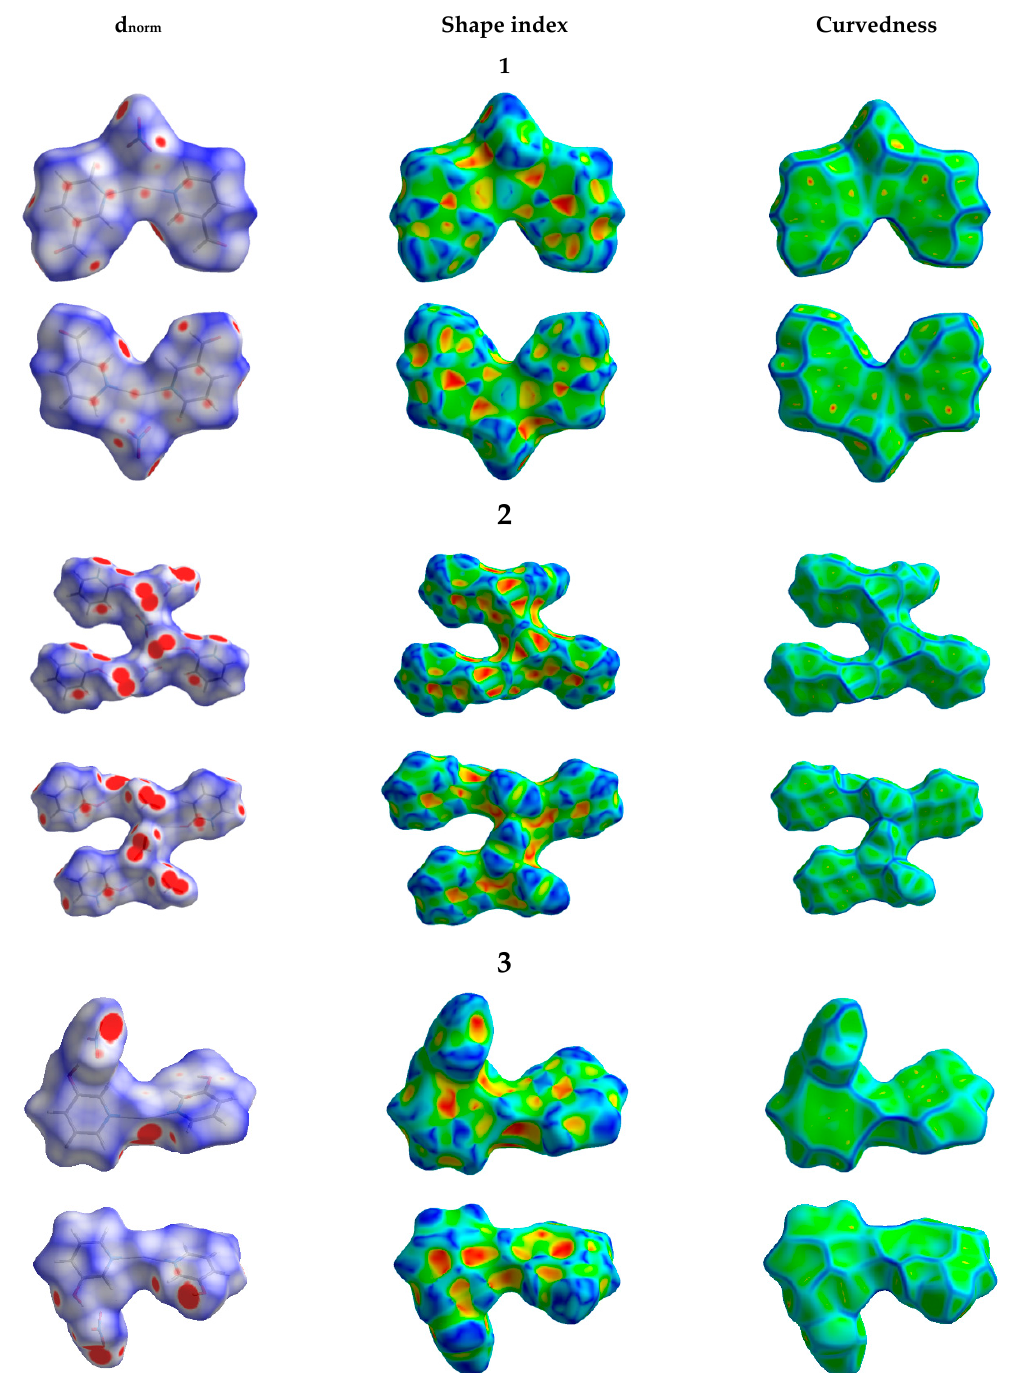
Figure 6. Hirshfeld analyses of [Ag(pyridine-3-carboxaldhyde) 2 NO 3 ]; ( 1 ), [Ag 3 (2-pyridone) 3 (NO 3 ) 3 ]; ( 2 ), and [Ag(3-hydroxypyridine) 2 ]NO 3 ; ( 3 ) complexes.